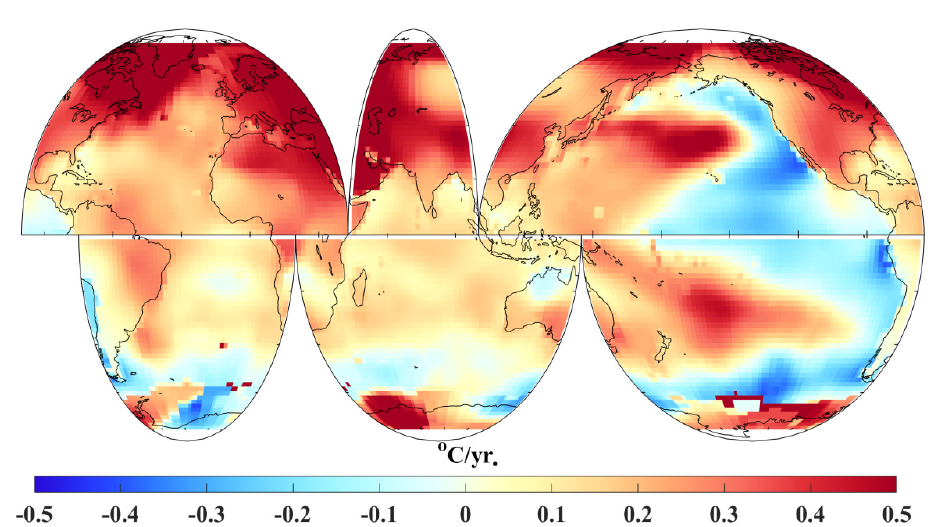
Figure 8. Spatial distributions of GMST linear trend with respect to the 1979–2013 average during the global warming slowdown period (data source: the land surface air temperature is from GHCNv4 [43] and the sea surface temperature is from ERSSTv5 [44]).